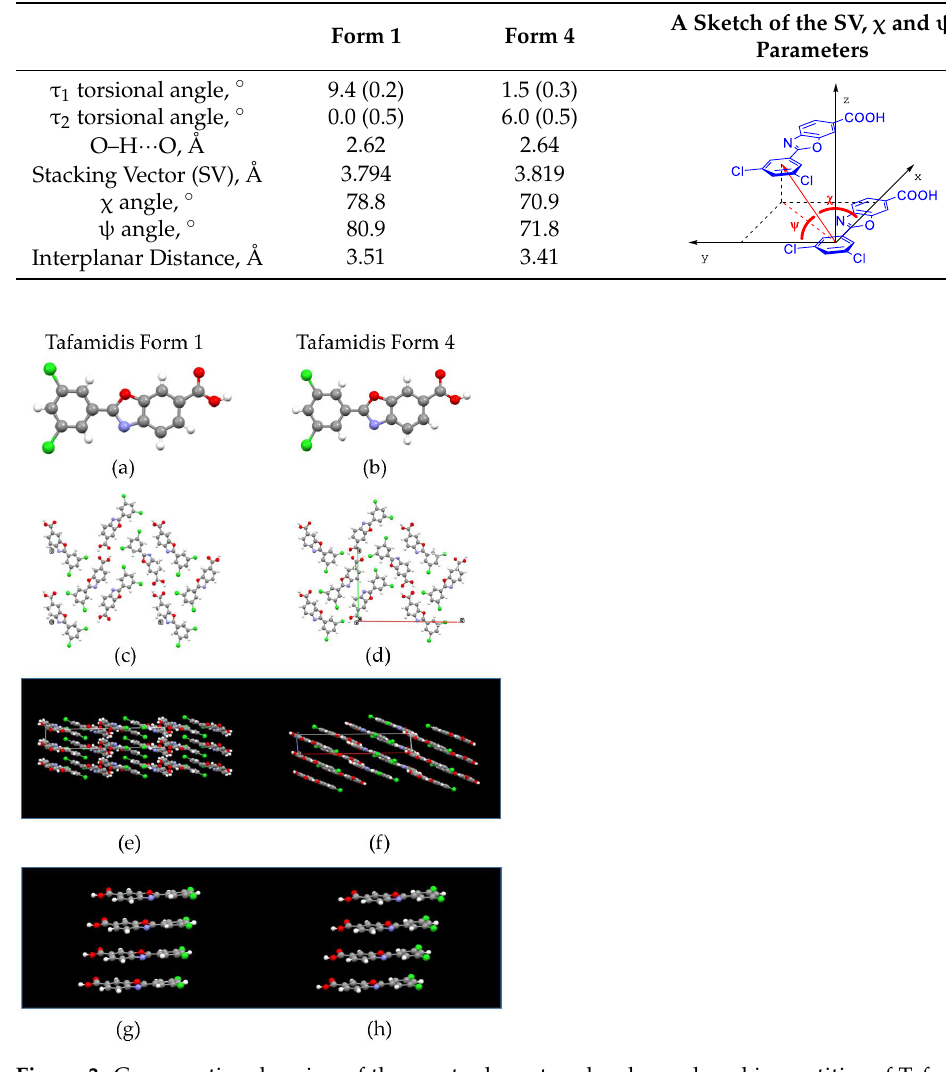
Figure 3. Comparative drawing of the most relevant molecular and packing entities of Tafamidis Forms 1 (left column) and 4 (right column) ( a , b ) the individual molecules; ( c , d ) the crystal packing viewed down c ; ( e , f ) the crystal packing viewed down b, where the largest differences are visible; ( g , h ) the π - π stacking occurring along c , characterized by significantly different interplanar vectors: 3.51 and 3.41 Å, respectively. Color codes: C (grey); H (white), N (blue), O (red) and Cl (green).